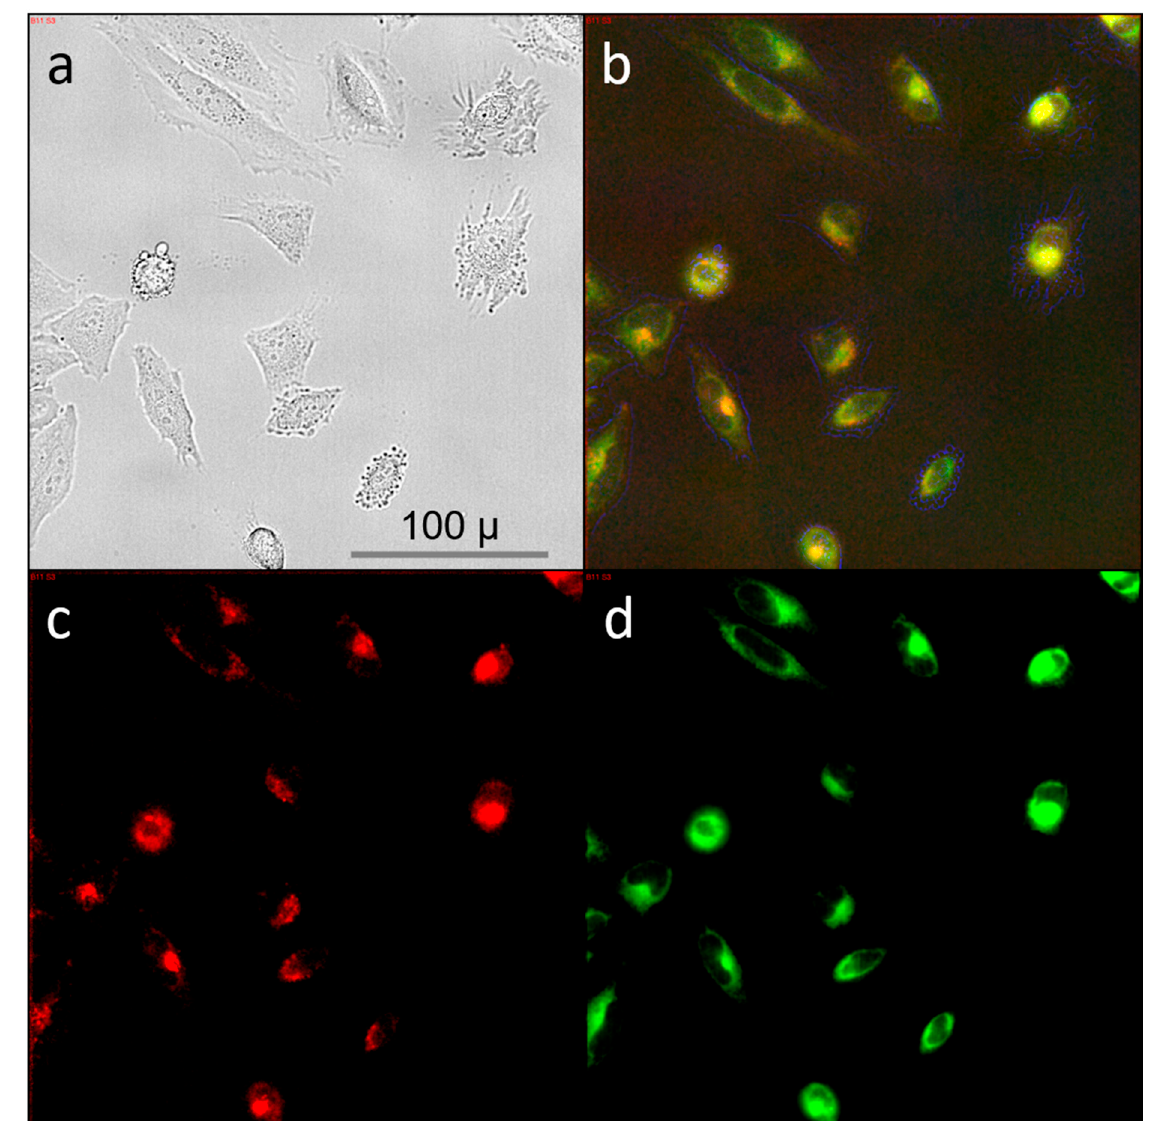
Figure 7. HeLa cells directly after incubation with curcumin were treated with the ER-tracker red. Shown are ( a ) bright field, ( b ) overlay of ( c ) ER-trackerRed labeled cells and ( d ) curcumin auto-fluorescing cells.